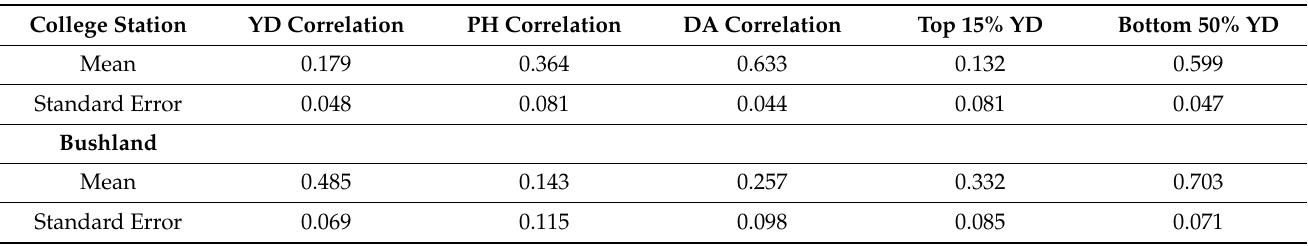
Figure 4. Variance components from genomic prediction models for grain yield, days to anthesis, and plant height. Percent of total variation explained (%Variation) is shown for Bushland (BU) and College Station (CS) environments with variation partitioned to additive, dominance, and residual effects (Error). Table 2. Prediction accuracies for single environment under cross-validation scheme CV1 using model M1. Mean correlations followed by standard errors are presented for grain yield (GY), plant height (PH), and days to anthesis (DA). Additionally, the accuracy to predict the top performing 15% and bottom performing 50% for YD are